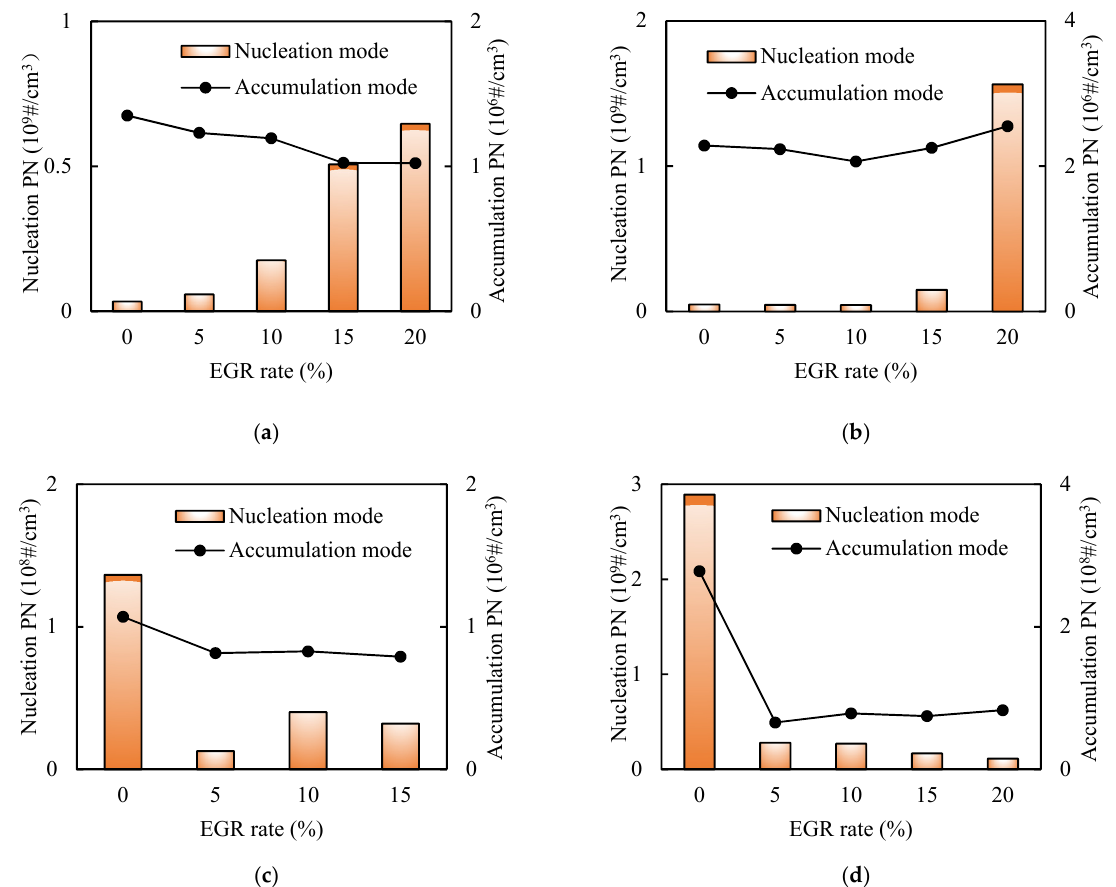
Figure 7. The number concentration of nucleation and accumulation mode particles varies with EGR. ( a ) 2000 r/min 10 bar; ( b ) 2000 r/min 15 bar; ( c ) 4000 r/min 10 bar; ( d ) 4000 r/min full load.